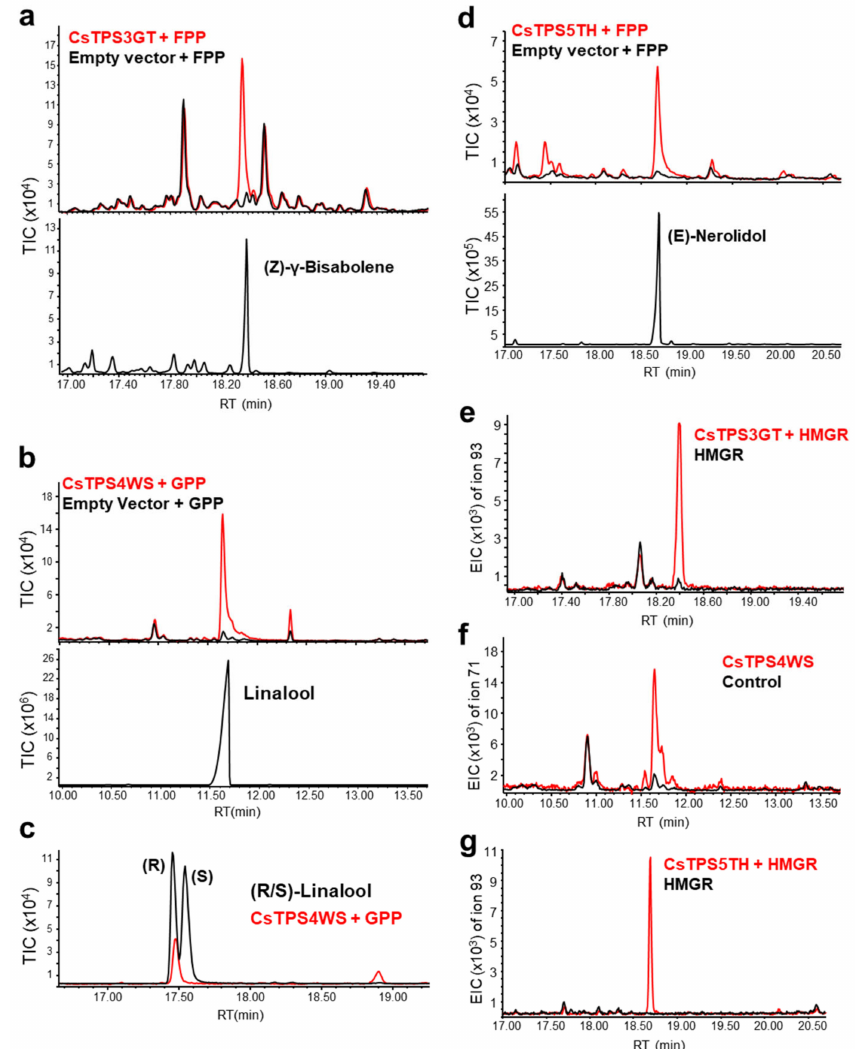
Figure 7. Functional characterization of CsTPSs. In vitro ( a – d ) and in vivo ( e – g ) characterization of CsTPS3GT, CsTPS4WS, and CsTPS5TH. The products were confirmed by comparison of reten- tion times and mass spectra with those of standards (Figure S7). TIC: total ion chromatogram; EIC: extracted ion chromatogram; RT: retention